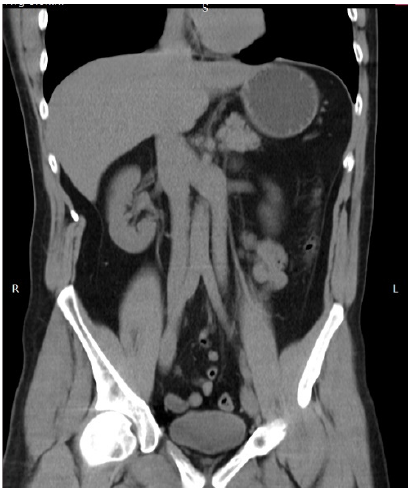
Figure 21. Bilateral double inferior vena cava (Type IIIA). Abdominal CT in the coronal plane. Surgical Considerations